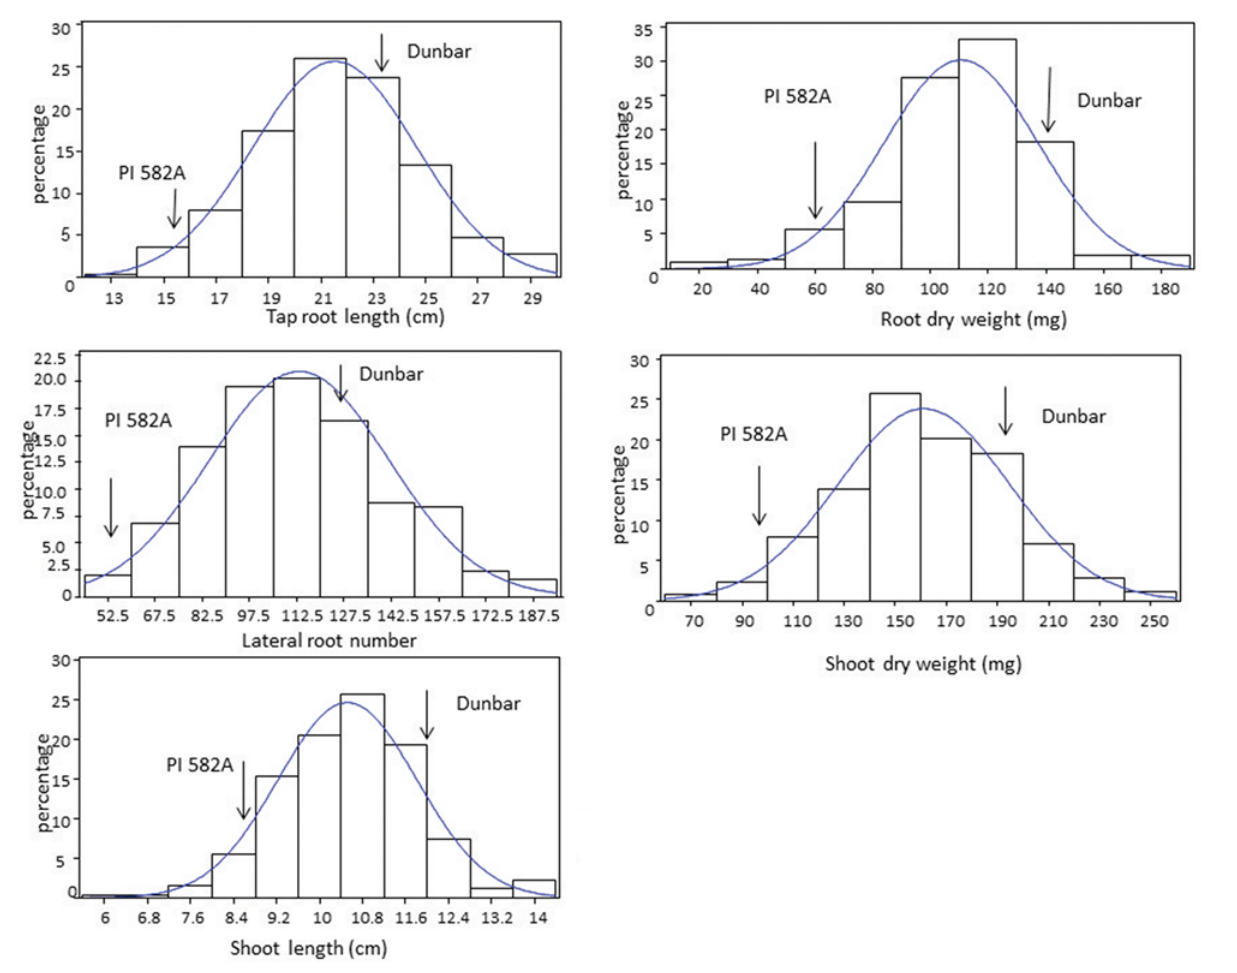
(Table 3). The LOD score peak of each of these four QTLs exceeded 3.0 and accounted for from 4.6 to 10.3 percent of phenotypic variation (Table 3, Fig. 4). With respect to the signifi- cant QTLs identified on chromosome 8 for TRL, LRN, SL and SDW, the allele conferring great- er length and number was contributed by the cultivated soybean parent, Dunbar